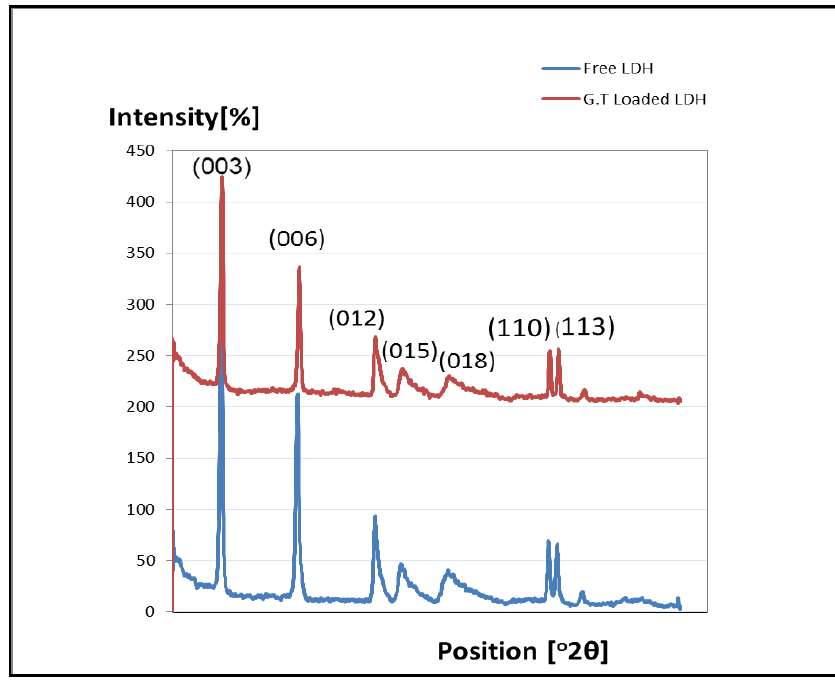
Figure 3. PXRD Diffraction pattern of unloaded MgAl-LDH and loaded green tea oil.